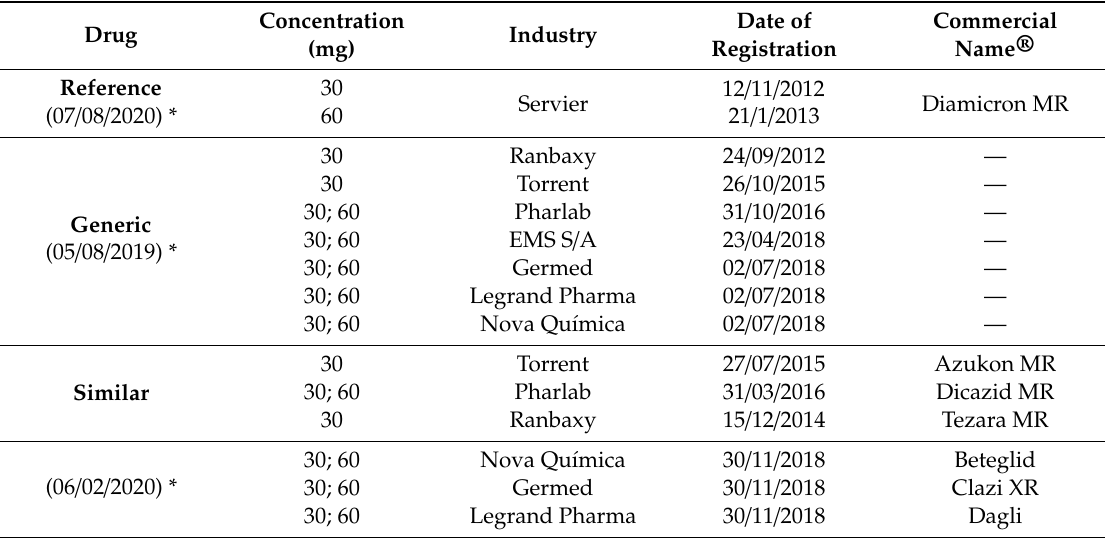
Table 4. Extended release drugs containing gliclazide available in the Brazilian